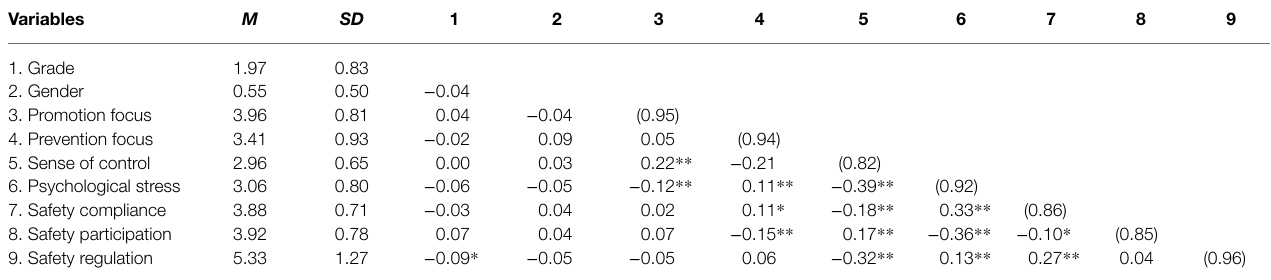
TABLE 2 | Descriptive statistics and variables correlation.